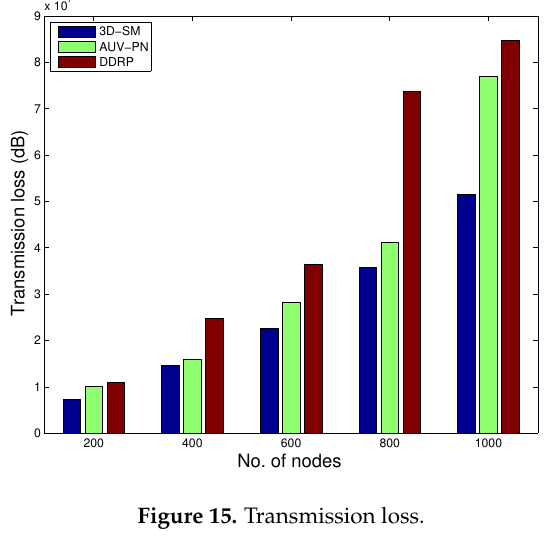
Figure 15. Transmission loss.